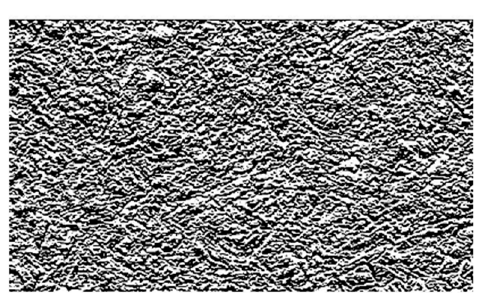
Figure 4. Image noise reduction.